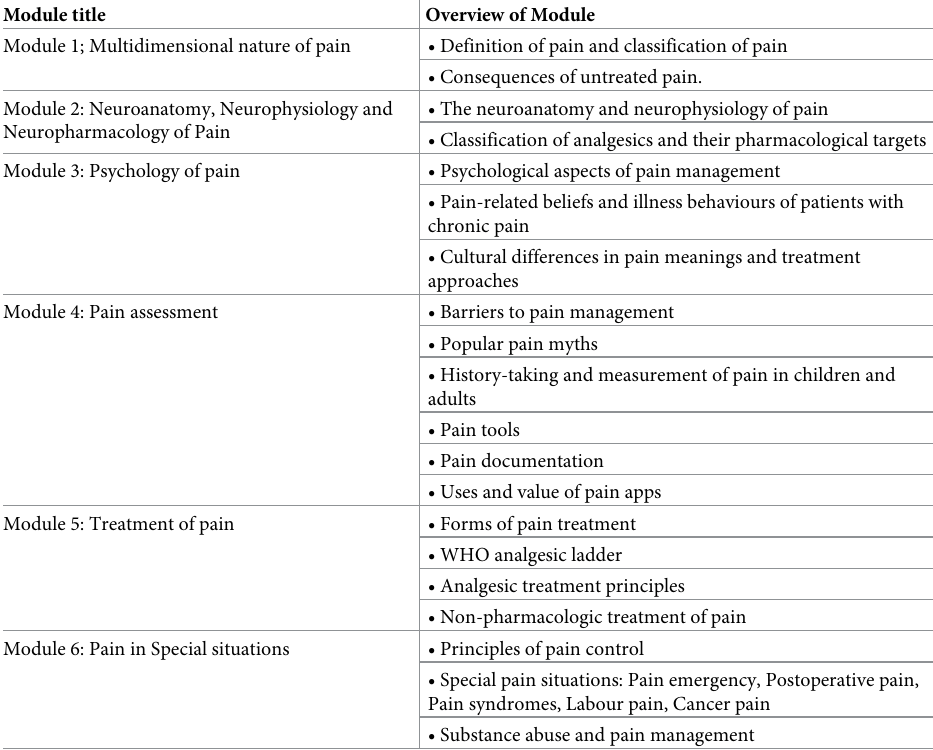
Table 1. Overview of the pain education curriculum of the online